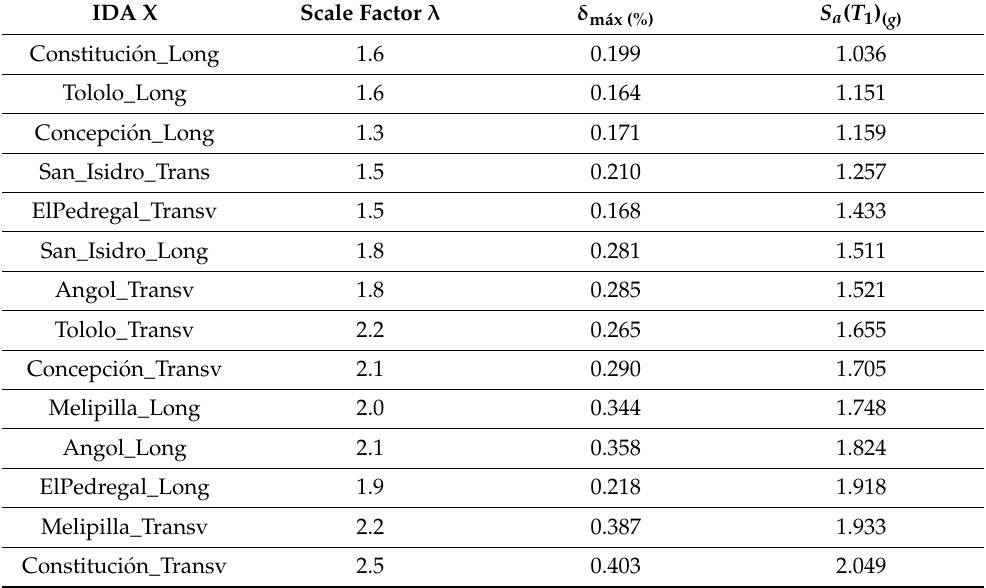
Table 3. Values of maximum drift of story δ max , spectral acceleration S a ( T 1 ) and collapse scale factor λ for the IDA curves obtained in the Y direction of the structure.